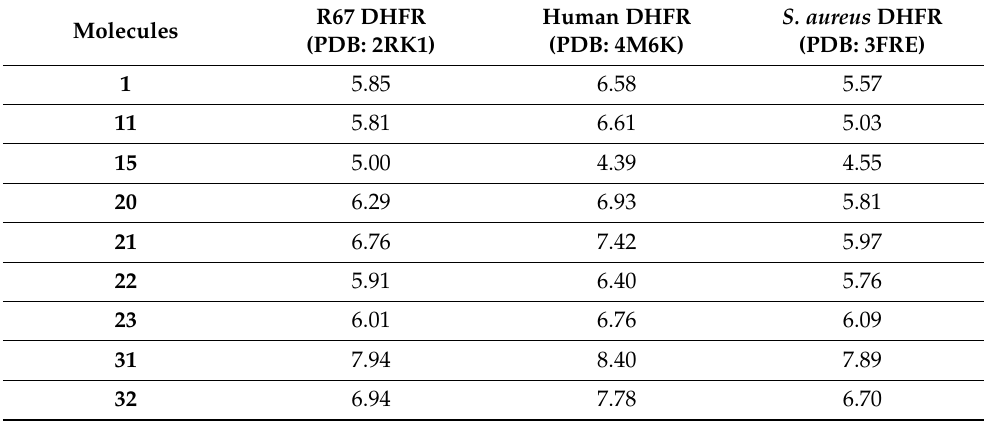
Table 2. Dissociation energies (kcal · mol − 1 ) of selected molecules from the active sites of selected dihydrofolate reductases, computed using the Autodock scoring functions on the highest-scoring docking